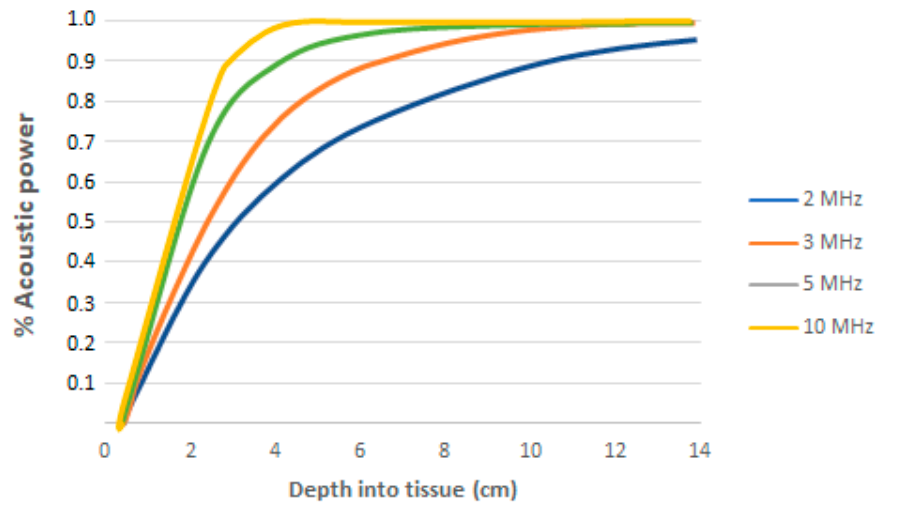
Figure 3. The fraction of the acoustic power leaving a transducer deposited in soft tissue up to a particular depth, depending on frequency. An absorption coefficient of 0.5 dB cm − 1 MHz − 1 has been assumed [6].